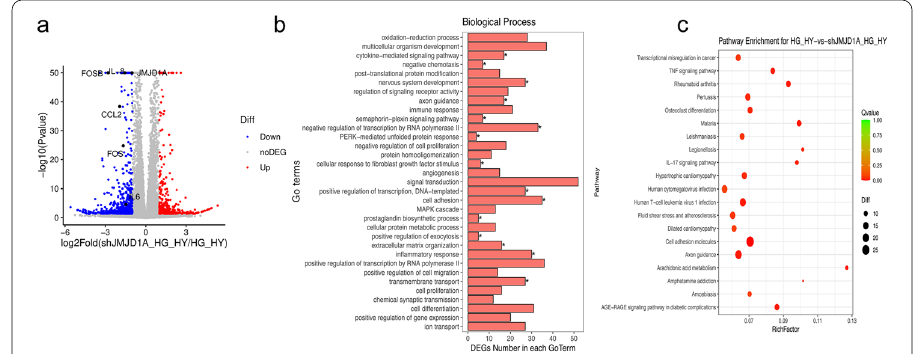
Fig. 9 Gene expression of shJMJD1A HUVECs induced by high glucose and hypoxia exposure by RNA-sEq. a Volcano plot was used to show the difference in gene expression values between the shCtrl and shJMJD1A induced by high glucose and hypoxia. Grey dotted line indicates the threshold for p < 0.05 and log FC < 2. Blue points represent down-regulated and red points represent up-regulated differentially expressed genes. GO ( b ) and KEGG enrichment analysis ( c ) of differentially expressed genes (correct_ P processes are indicated in red, and red bubbles show KEGG